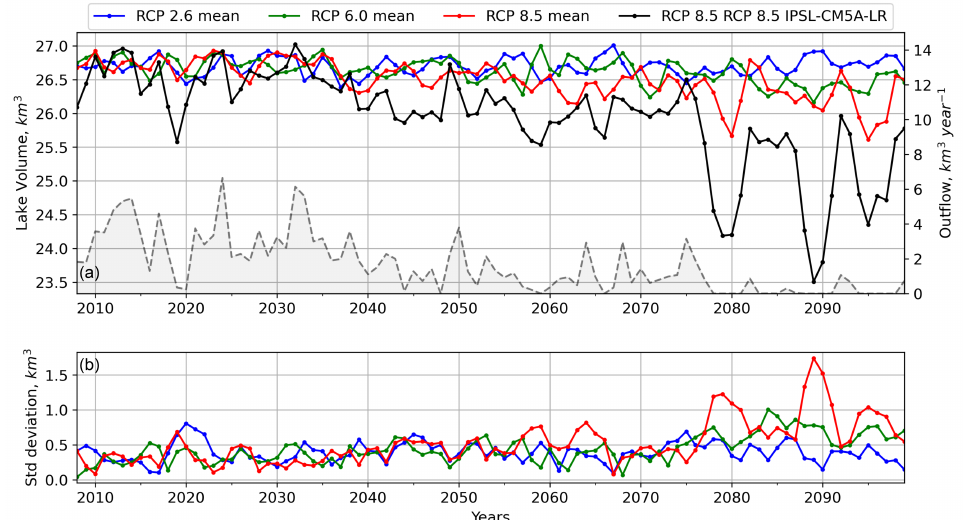
Figure 4. Mean annual values of the Small Aral Sea volume depending on the RCP scenarios, averaged between 4 models ( a ); IPSL-CM5A-LR model under RCP 8.5 scenario is shown in black as the most adverse case; a dashed line shows annual values of the outflow under that scenario. Standard deviations of the mean values for each scenario ( b ).